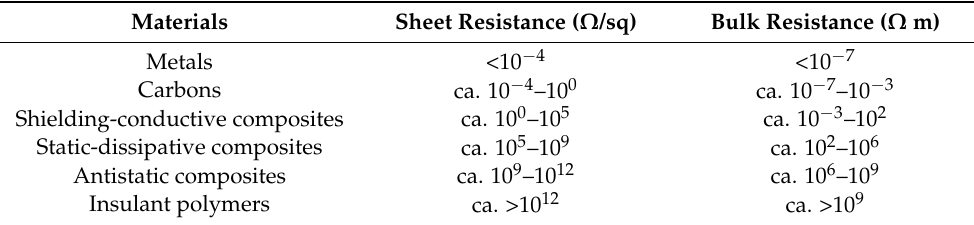
Table 1. ESD materials